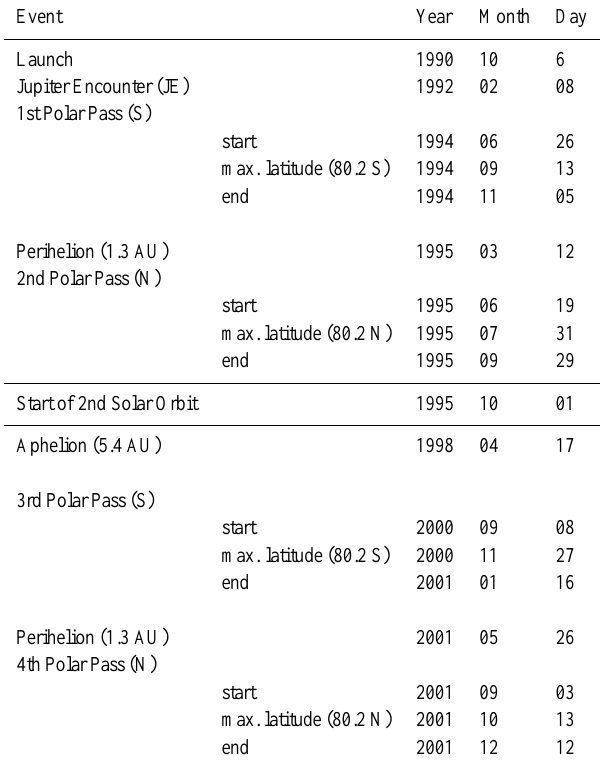
Table 1. Some key dates in the Ulysses mission